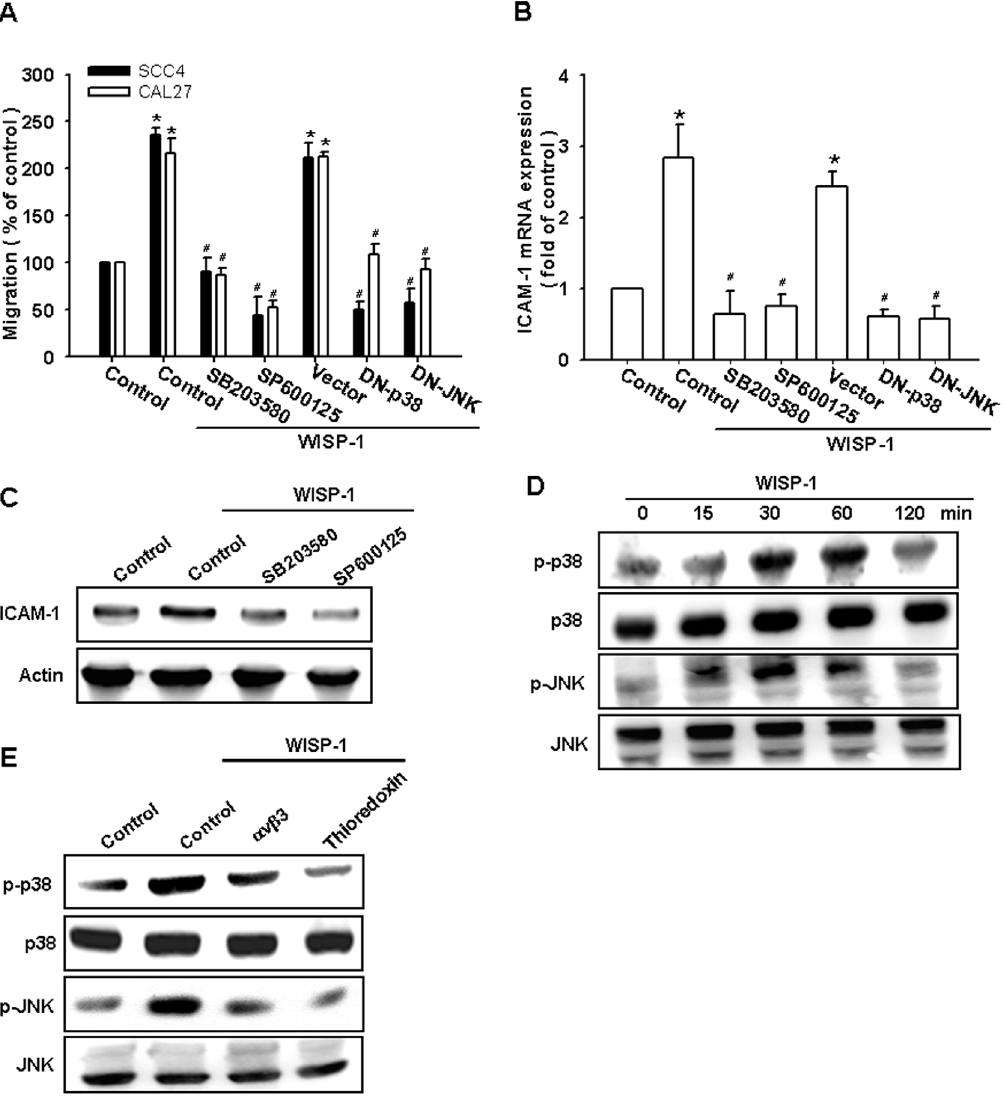
Figure 4. WISP-1 increases cell motility and ICAM-1 expression through the c-Jun N-terminal protein kinase (JNK) and p38 pathways. (A–C) Cells were pretreated for 30 min with SB203580 (10 m M) and SP600125 (10 m M) or transfected with dominant negative (DN) mutants of p38 and JNK for 24 h followed by stimulation with WISP-1. The in vitro migration and ICAM-1 expression were measured by the Transwell assay, qPCR, and western blotting (n=5). (D) SCC4 cells were incubated with WISP-1 for the indicated time intervals, and p38 and JNK phosphorylation was examined by western blotting (n=4). (E) SCC4 cells were pretreated for 30 min with a v b 3 mAb or thioredoxin for 30 min followed by stimulation with WISP-1 for 60 min, and JNK and p38 phosphorylation was determined by western blotting (n=5). Results are expressed as the mean 6 SEM; *, p , 0.05 compared with the control; # , p , 0.05 compared with the WISP-1–treated group.